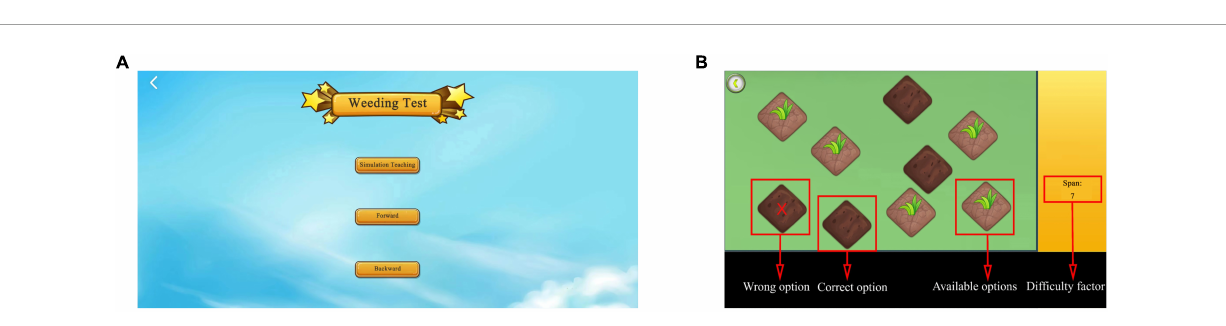
FIGURE3 Weeding test. (A) Login to the weeding test interface. The weeding test includes forward and backward, and simulation exercises are required before the test. (B) Test interface. The screen in the weeding test. Weeds will disappear when selected correctly; when selected incorrectly, the weed will exhibit “ × ”. Adapted from